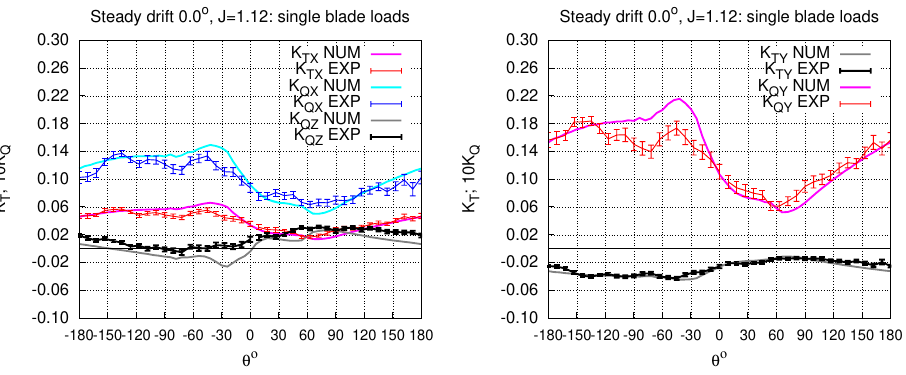
Figure 7. Propulsive performances of the model hull in ahead motion at zero drift angle, J = 1.12. Single blade contribution to thrust, torque and spindle moment coefficients ( left ) and to the transverse force and bending moment ( right )